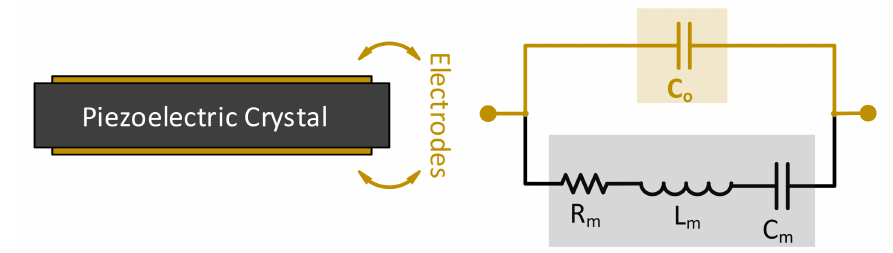
Figure 2. ( Left ) microbalance crystal diagram. ( Right ) Corresponding BVD electrical